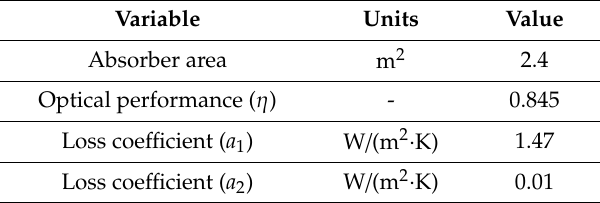
Table 1. Technical specifications of the Apricus evacuated tube collector (ETC)-30 solar collector [29].